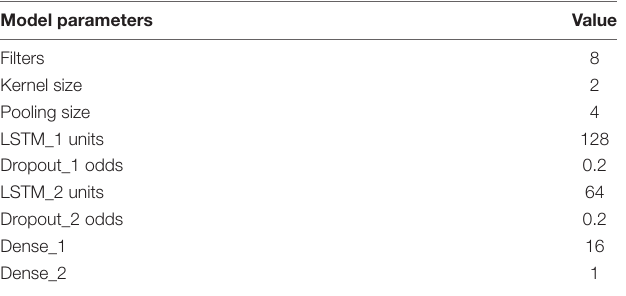
TABLE 2 | Parameters of the Post-LOCA prediction model. TABLE 3 | Classifier verification results.